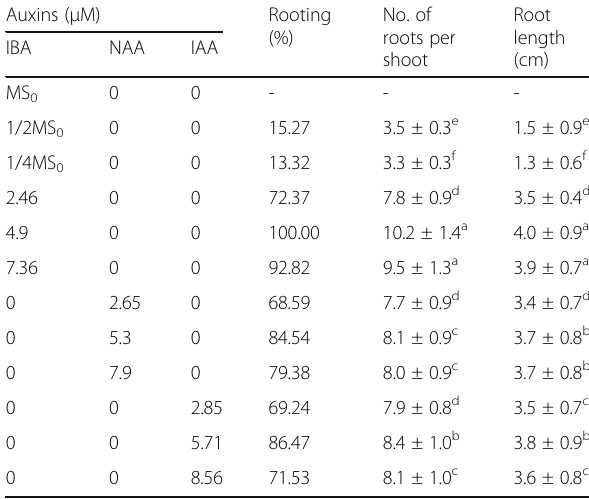
Table 3 Effect of auxins on root induction in in vitro- regenerated shoots of Tricholepis roylei in half-strength MS medium after 4 weeks of culture